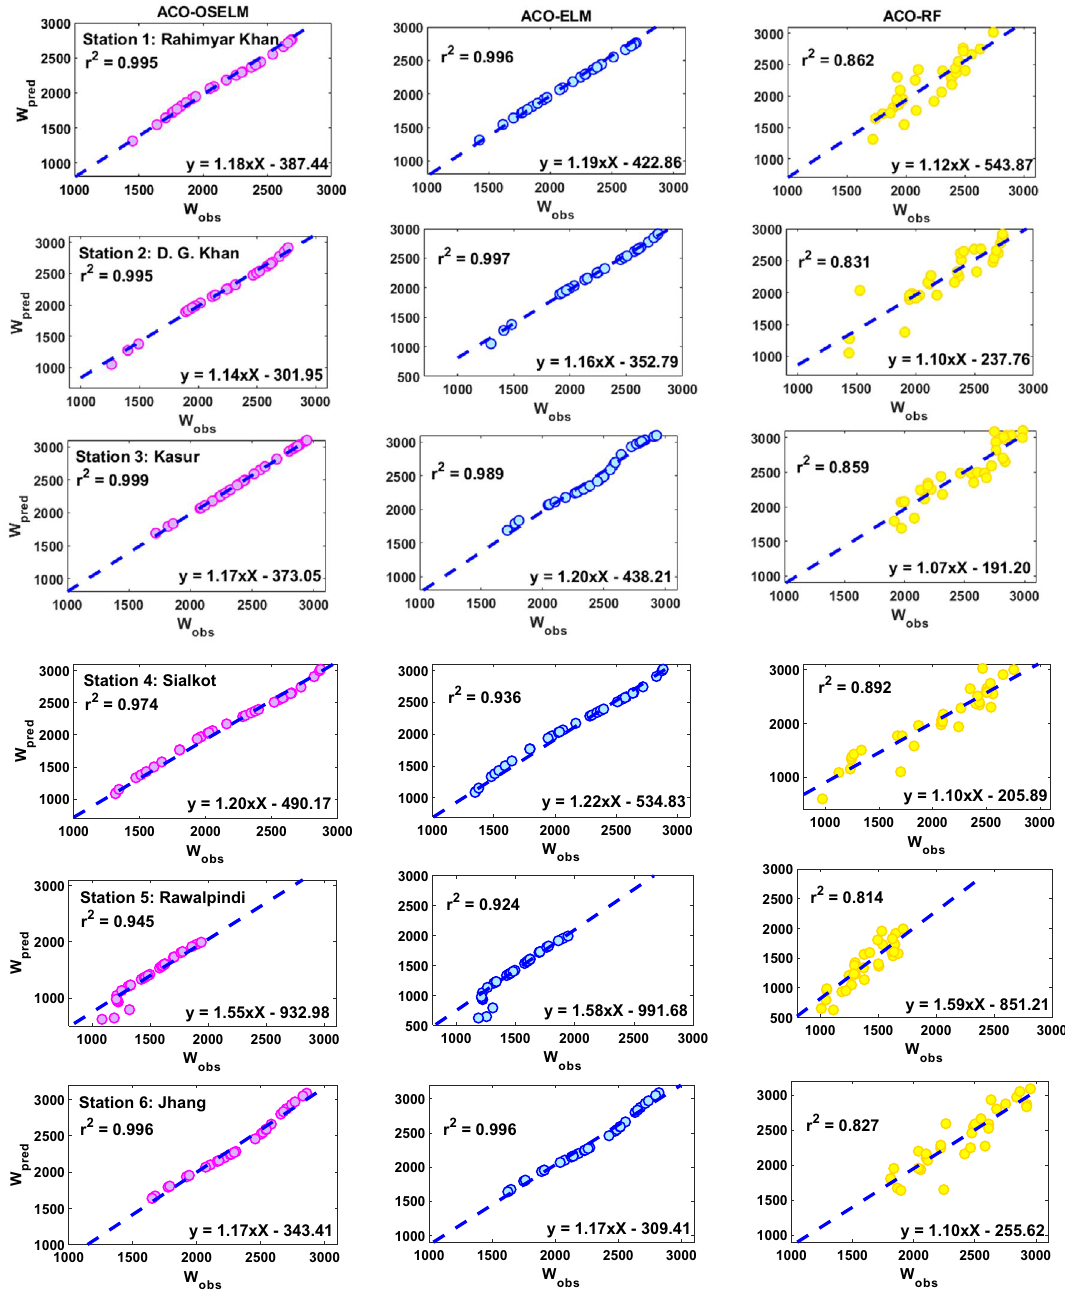
Figure 7. Scatterplots of the predicted (W pred ) and observed wheat yield (W obs ) (kg ha −1 ) in the testing phase of the ACO-OSELM versus ACO-ELM and ACO-RF models including the coefficient of determination ( r 2 ) and a linear fit inserted in each panel for the tested study zones. Note : Each point represents each year’s data in the testing